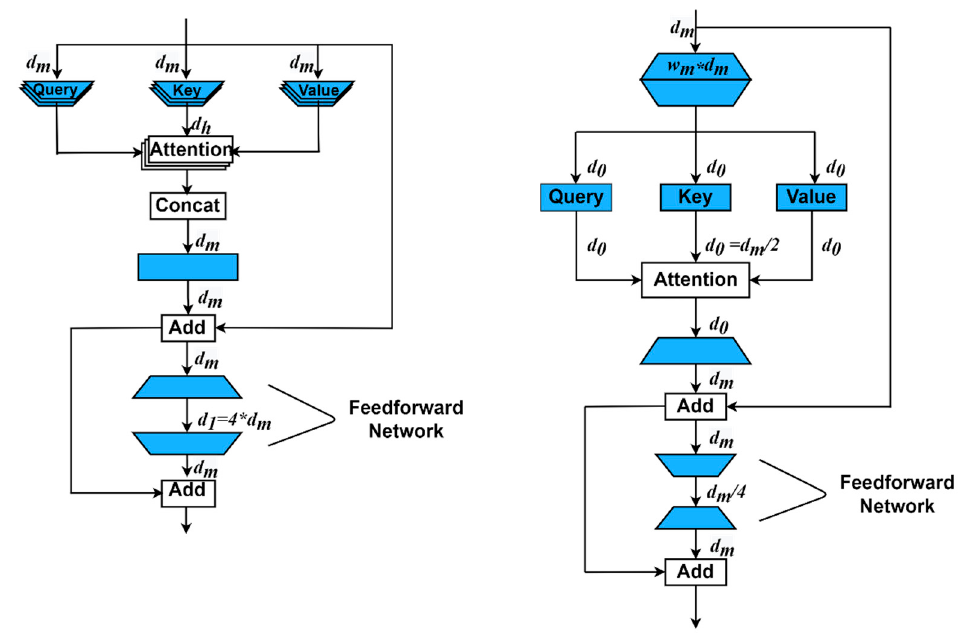
Figure 3. Comparison of Transformer encoder and Transformer encoder combined with GLTs. The left is the standard Transformer encoder. The right is the Transformer encoder combined with GLTs. The hidden vector H , which is output by the local RNN module, is used as the input to the Transformer encoder with the GLTs. Suppose the number of layers of GLTs is N . In the expansion stage, in (cid:100) N /2 (cid:101) linear layers, the d m -dimensional input is projected into the high-dimensional space with d max = w m d m , where w m is expanded dimensional coefficients; similarly, in the reduction stage, the d max -dimensional vector is projected into the d 0 -dimensional space using the remaining N − (cid:100) N /2 (cid:101) layers, projecting the d max dimensional vector into the d 0 dimensional space.